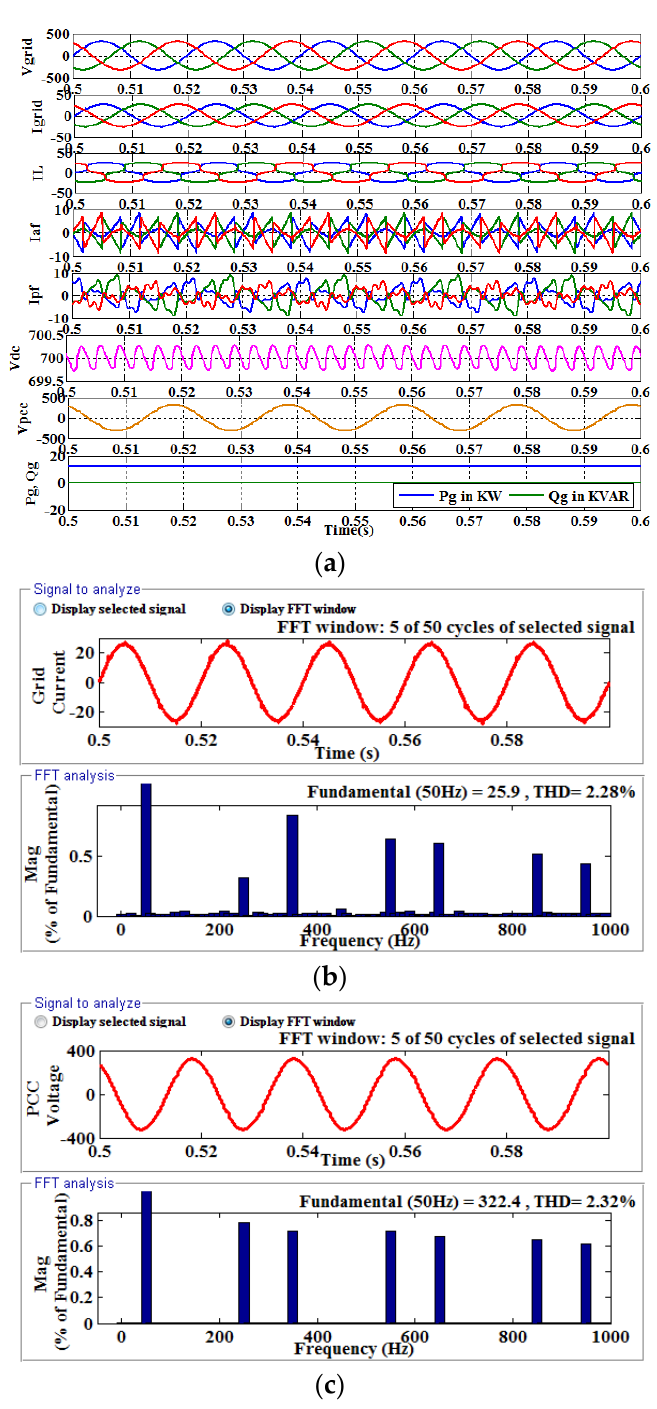
Figure 5. ( a ) Grid voltage and current, Load current, Injected active filter current, Injected passive filter current, DC link voltage, PCC voltage, Active and Reactive power drawn from the grid by the load connected at PCC for inductive load in grid-connected mode, ( b ) FFT analysis of compensated grid current with inductive load, and s( c ) FFT analysis of compensated PCC voltage with inductive